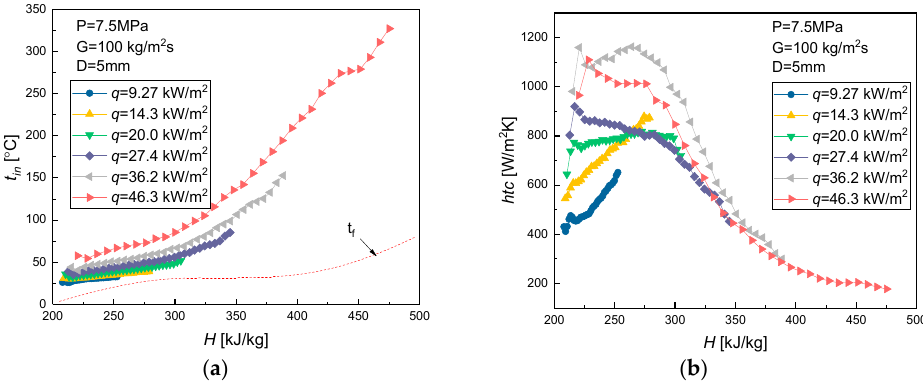
Figure 7. Variations in inner-wall temperatures and heat transfer coefficients for various bulk enthalpies at different heat fluxes for the pressure and mass flux of 7.5 MPa and 100 kg/m 2 s, respectively. ( a ) Temperature; ( b ) Heat transfer coefficient.